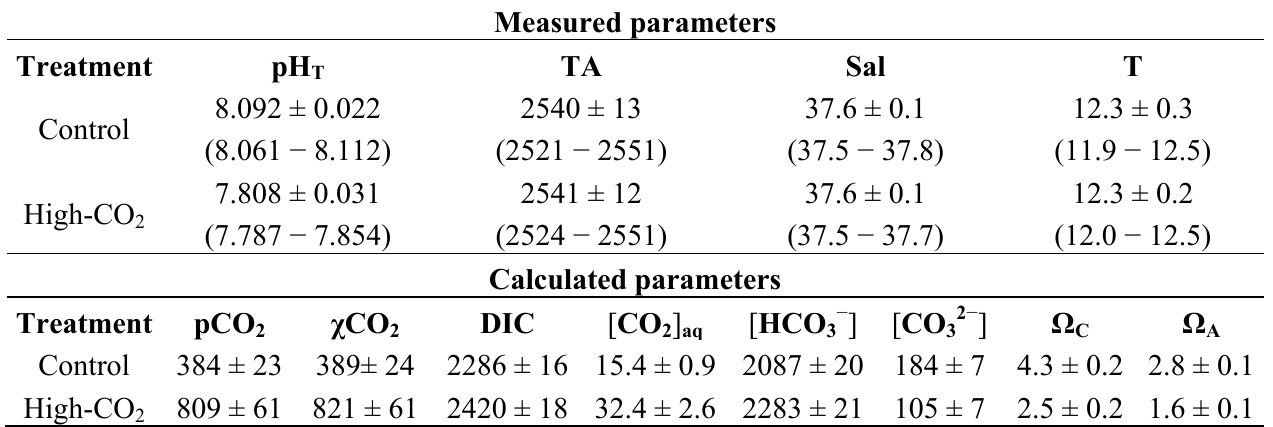
Table 1. Parameters of the seawater carbonate system in the aquaria for each treatment. , salinity and temperature were used to calculate all the other Total alkalinity, pH T parameters using the CO2calc software (USGS). For the four measured parameters we report the values as mean ± SD (N = 4) and range (in brackets). All other calculated parameters are expressed as mean ± SD (N =